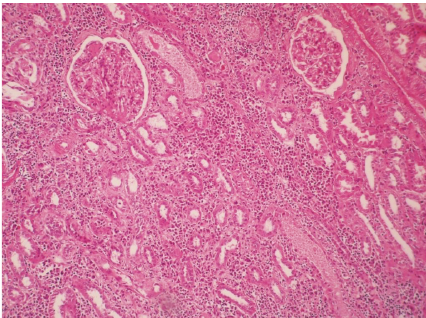
Figure4:Thereismarkedmixedinflammationinrenalparenchyma in the background of diabetic nephropathy (nodular sclerosis). H&E